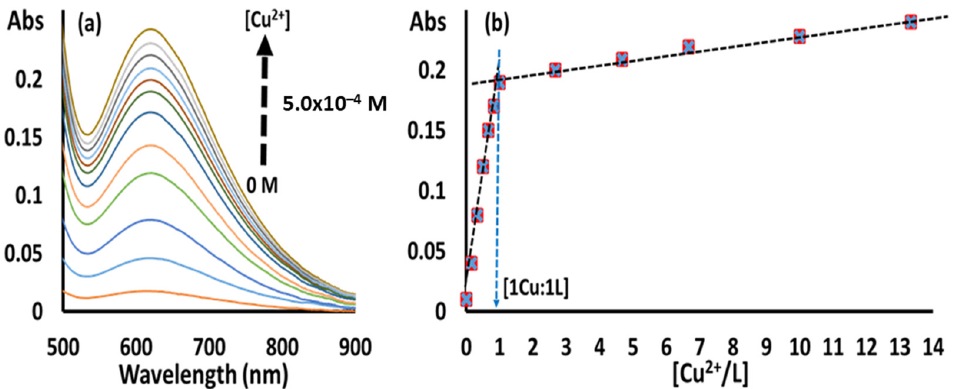
Figure 6. Plot of absorbance of Cu(II)-L interaction at varying concentrations of Cu(II) ( a ); Job’s plot of Cu(II)-NNNO complex 1 at λ max = 620 nm ( b ).